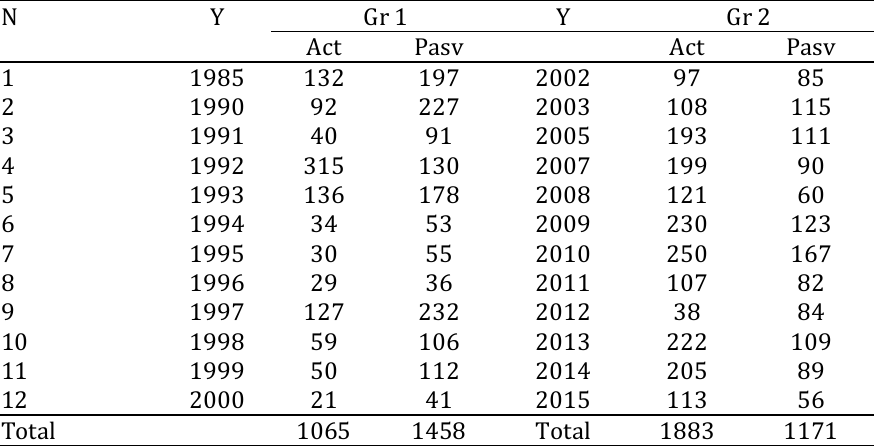
Table 2. Distribution of Active and Passive Voice per each Year of